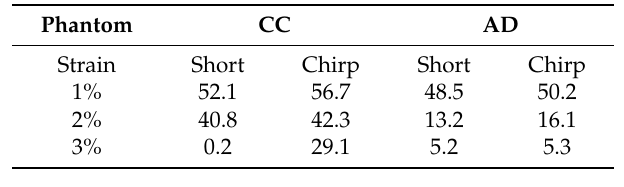
Table 3. CNRe measured for lesion phantom on Figure 24.